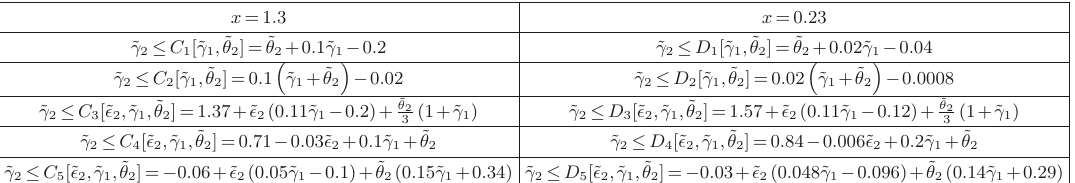
Table 1 . Lists of constrains for two values of x = µ 0 in the right column, stemming from the Routh-Hurwitz, stability and second law criteria.